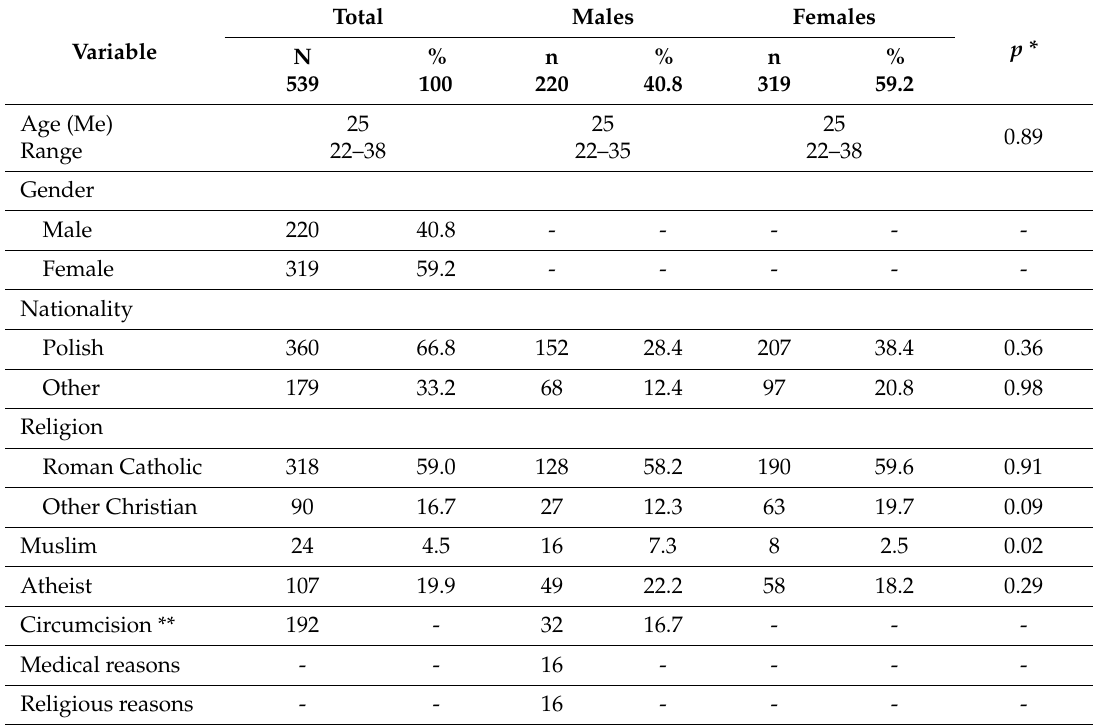
Table 1. Demographic characteristics of the participants, Poland, 2013–2016; n =